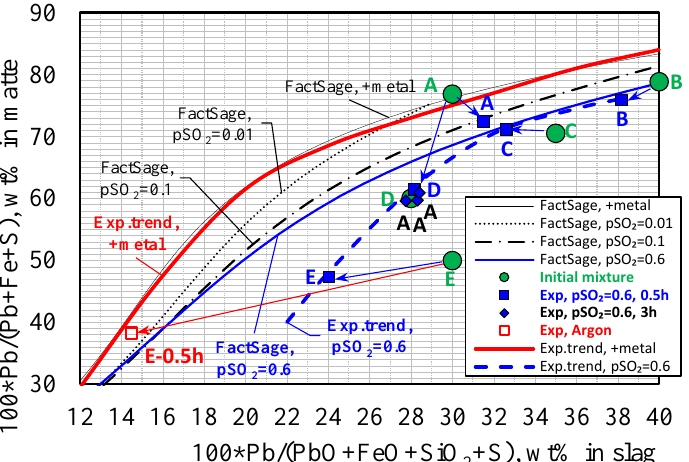
Figure 13. Compositional movement within 0.5–3 h for the slag–matte–metal–tridymite equilibrium in the Pb-Fe-O-Si-S system. Green circle = initial starting mixture; Blue square/diamond = after 0.5/3 h equilibration in CO/CO 2 /SO 2 /Ar atmosphere ( p SO 2 = 0.6), respectively; Red open square = after 0.5 h equilibration in Ar